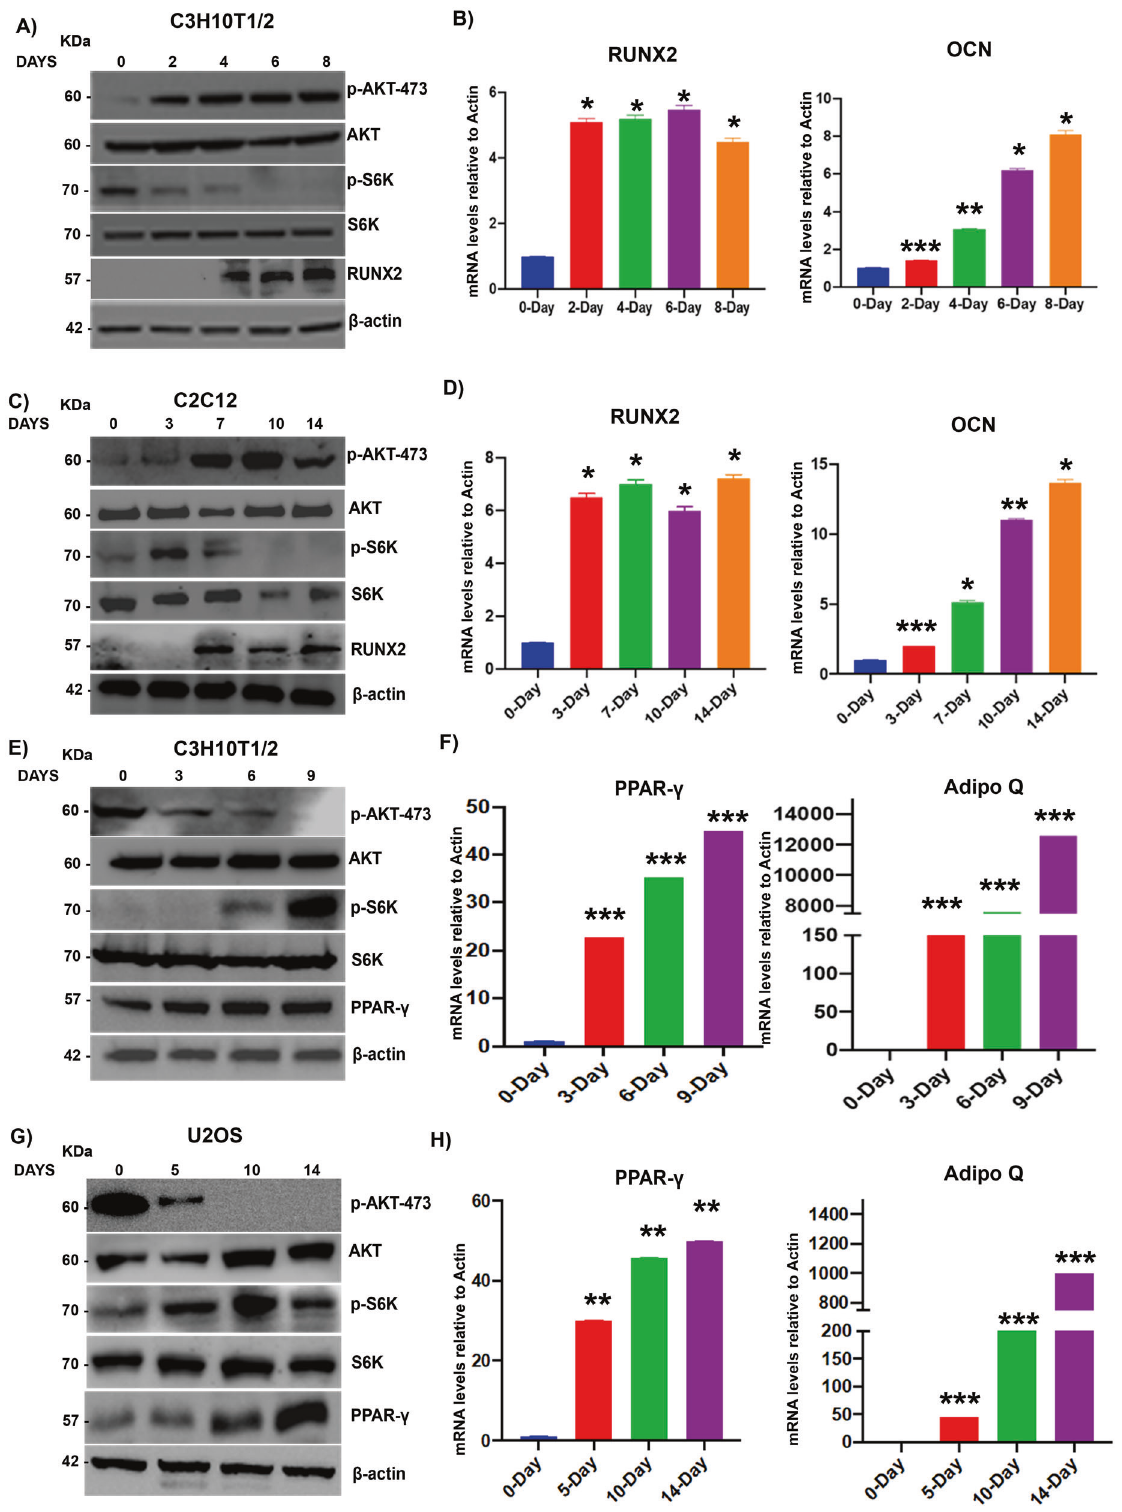
Fig. 1 mTORC1, but not mTORC2, is indispensable for adipogenesis and vice versa. Murine MSCs (C3H10T1/2) were subjected to osteogenic differentiation, and lysates were collected at the indicated time points and subjected to A Western blot analysis using the indicated antibodies and B RT-PCR. C C2C12 cells (skeletal myocytes) were subjected to osteogenic transdifferentiation, and cell lysates were subjected to Western blotting and D RT-PCR. Murine MSCs were subjected to adipogenic differentiation, and cell lysates were collected at the indicated time points and E subjected to Western blotting and F RT-PCR as indicated. U2OS cells were subjected to adipogenic transdifferentiation, and cell lysates were collected and G subjected to Western blot analysis and H RT-PCR analysis as indicated. Mean ± S.E. M.; N = 3, * p < 0.1 versus control, ** p < 0.01 versus control; *** p < 0.001 versus control. RUNX2 runt-related transcription factor 2, OCN Osteocalcin, Adipo Q adiponectin Q, PPAR- γ peroxisome proliferator-activated receptor gamma. Cell Death Discovery (2022)